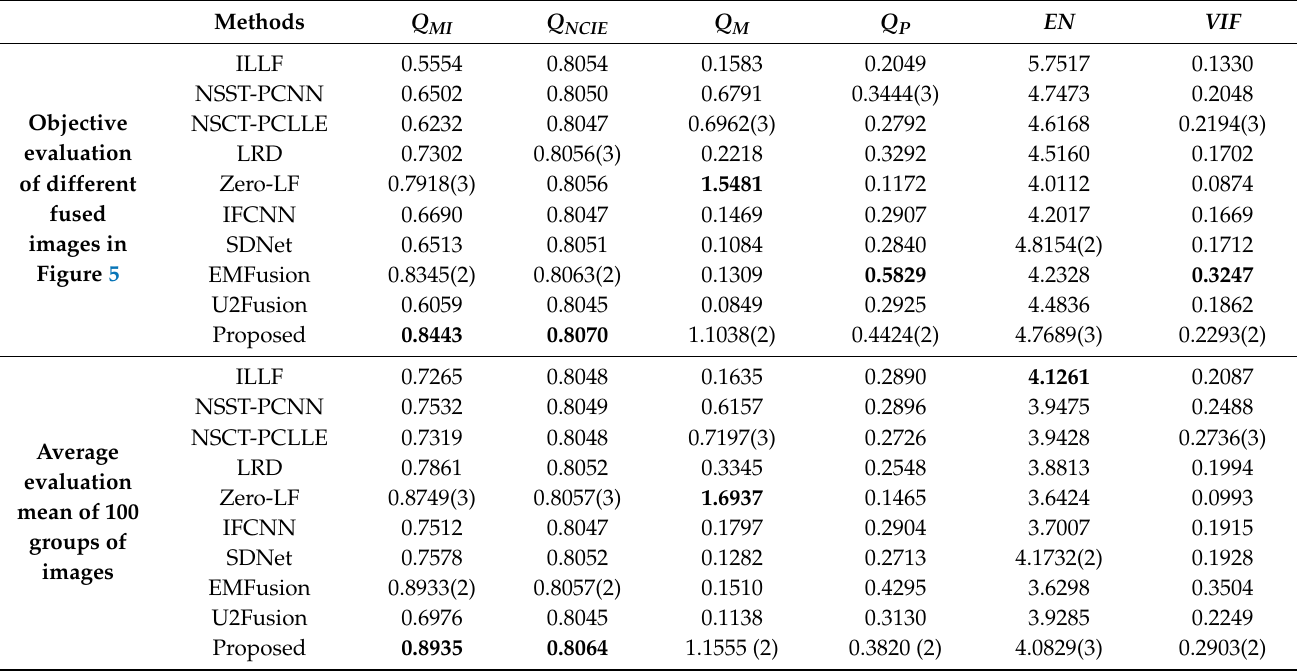
Table 2. Comparison of performance of proposed fusion method with those of nine existing methods on CT-MRI images; the best results are shown in bold.